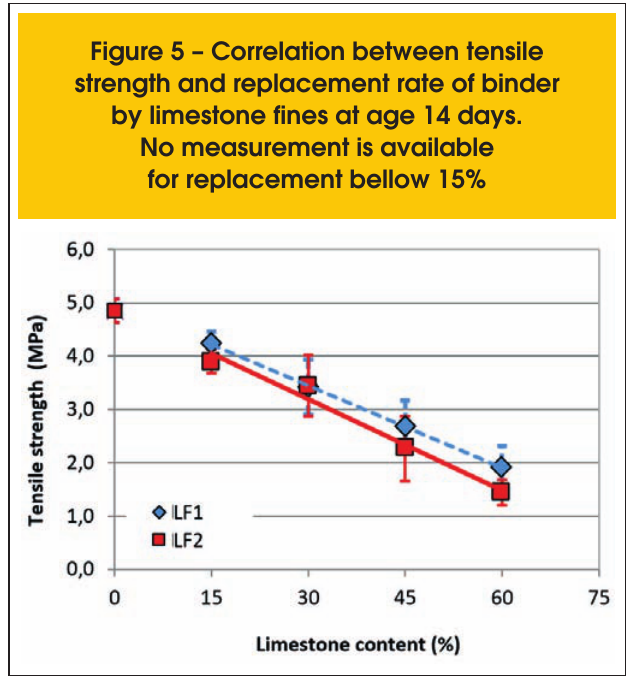
Figure 5 – Correlation between tensile strength and replacement rate of binder by limestone fines at age 14